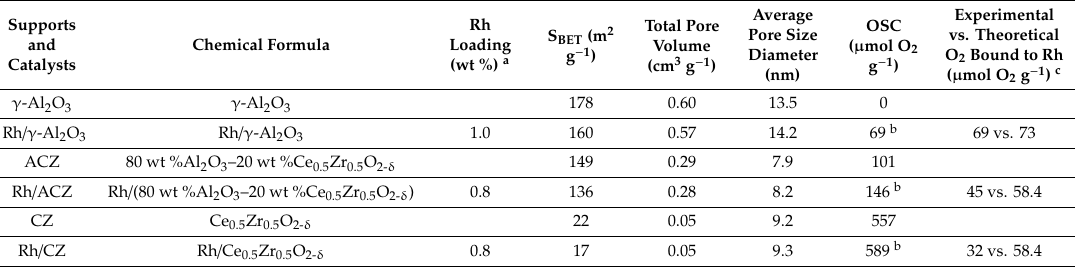
Figure 3. H 2 -TPR profiles of ( a ) the γ -Al 2 O 3 , ACZ and CZ supports and ( b ) the corresponding Rh catalysts. Table 1. Textural characteristics and oxygen storage capacities (OSC) of the support materials and the corresponding fresh Rh catalysts.